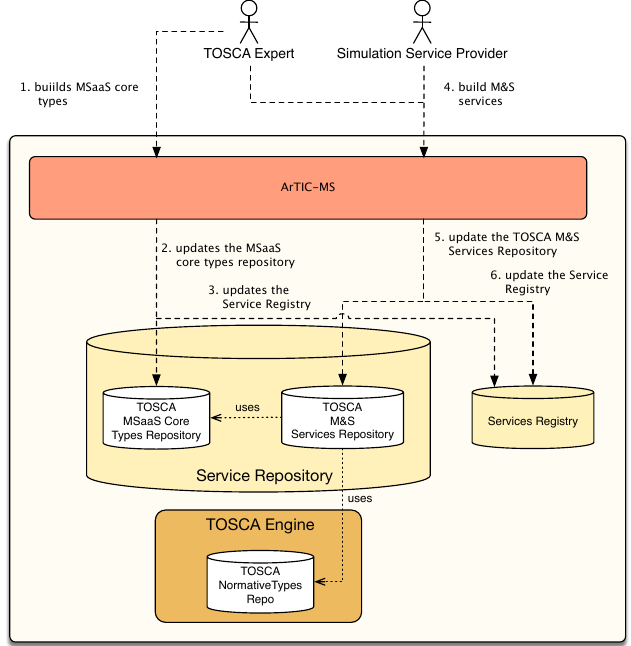
Figure 10. Use case for building a TOSCA-based M&S